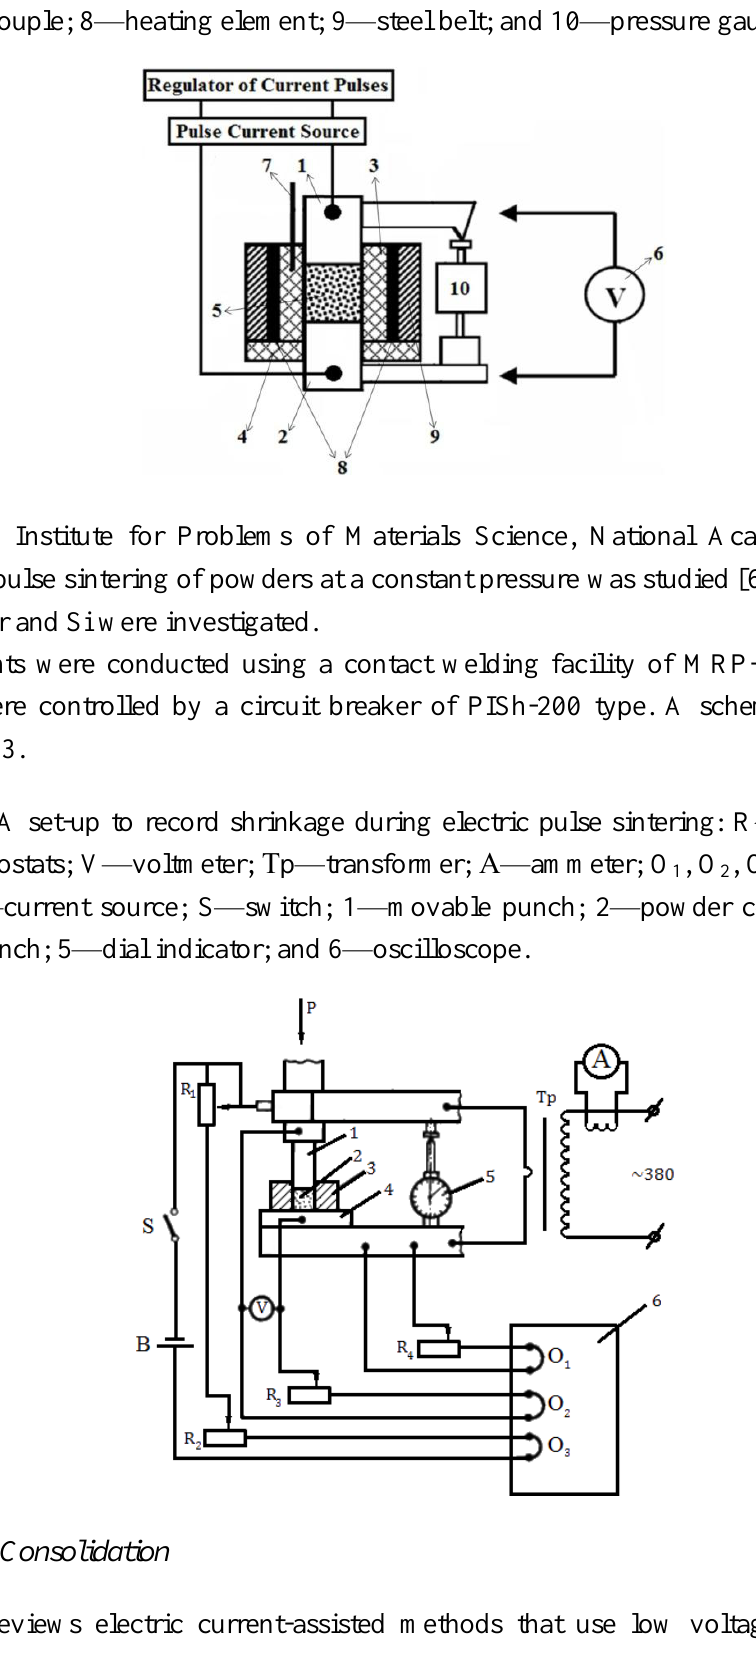
Figure 12. Block-diagram of the electric pulse sintering facility to sinter SiC ceramics: 1 and 2—electrodes; 3—die; 4—insulating washer; 5—powder compact; 6—voltmeter; 7—thermocouple; 8—heating element; 9—steel belt; and 10—pressure gauge.